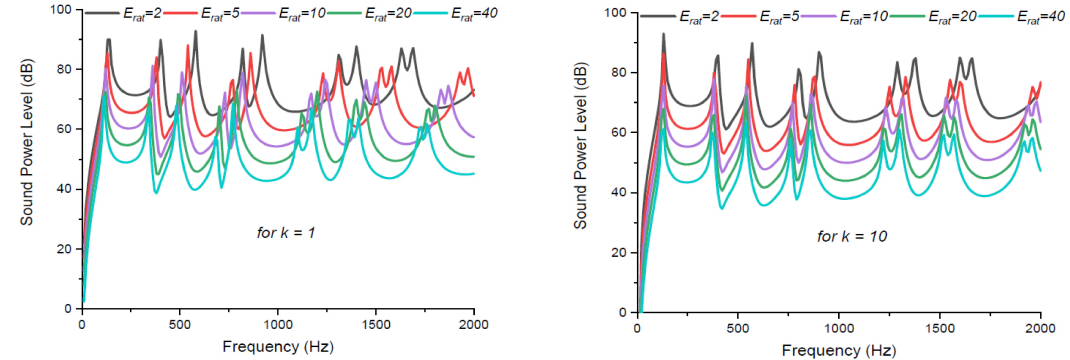
Figure 10. SPL’s peak shift with E rat for power-law index, k = 1 and